Question: Describe this figure in one sentence.
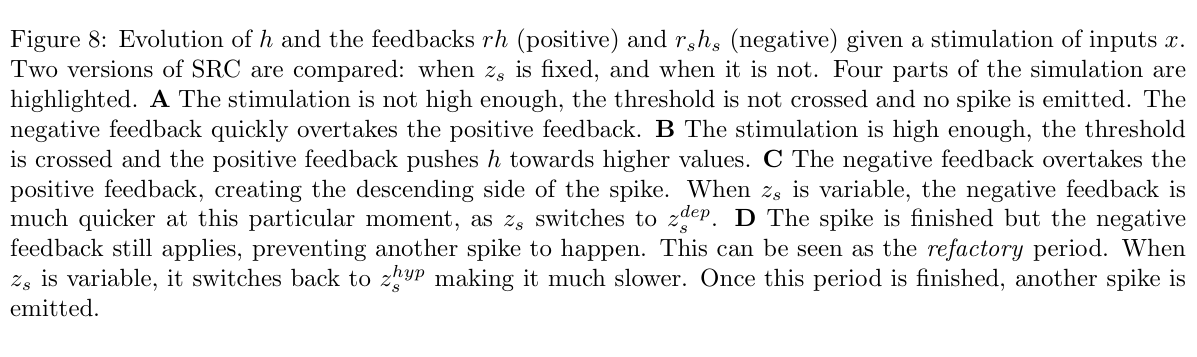
Answer: shows a simulation of the spike generation part of SRC when some stimulation is applied. Two versions of SRC are compared: whether zs is fixed or not. The advantage of the variable zs is twofolds. First, the duration of the spike is smaller, thanks to a very fast descending side. Then, during the refactory period, zs switches back to zhyp s , making the convergence of hs towards h much slower. This decoupling between the convergence speed of hs during the spike and during the refactory period allows to control the duration of this period without any impact on the spike duration.